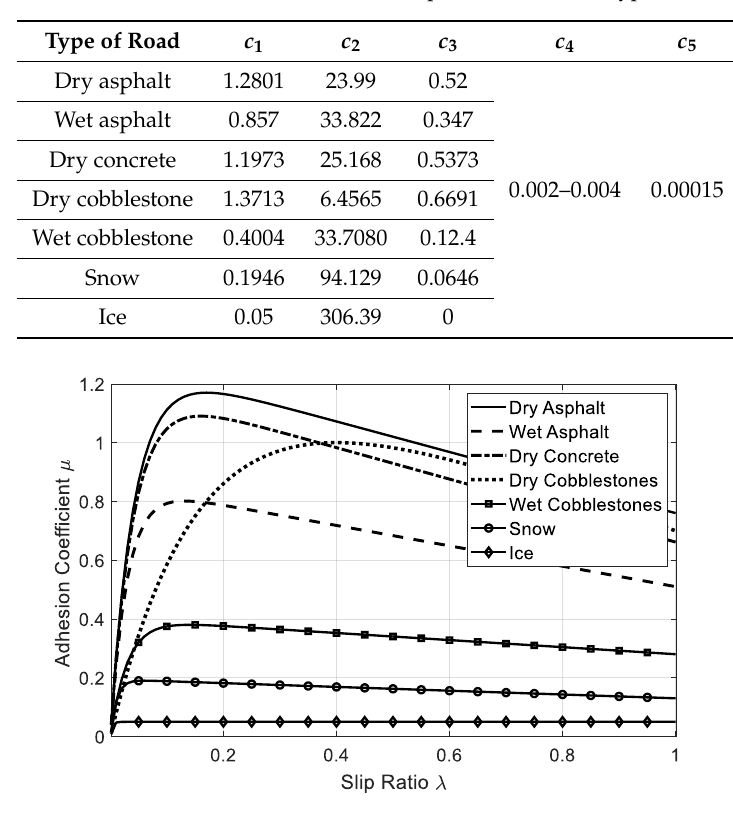
Figure 5. Different µ − λ characteristics by Burckhardt tire-road